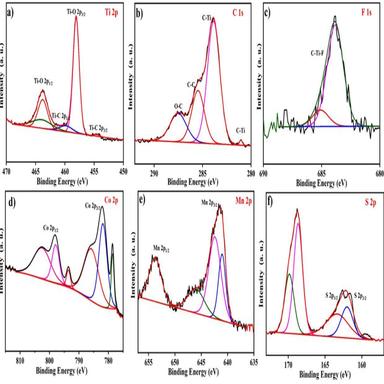
(a) XPS deconvoluted spectra of hybrid MCS-MXene (1:2) (a) Ti 2p; (b) C 1s; (c) F 1s; (d) Co 2P; (e) Mn 2p; (f) S 2p orbitals.